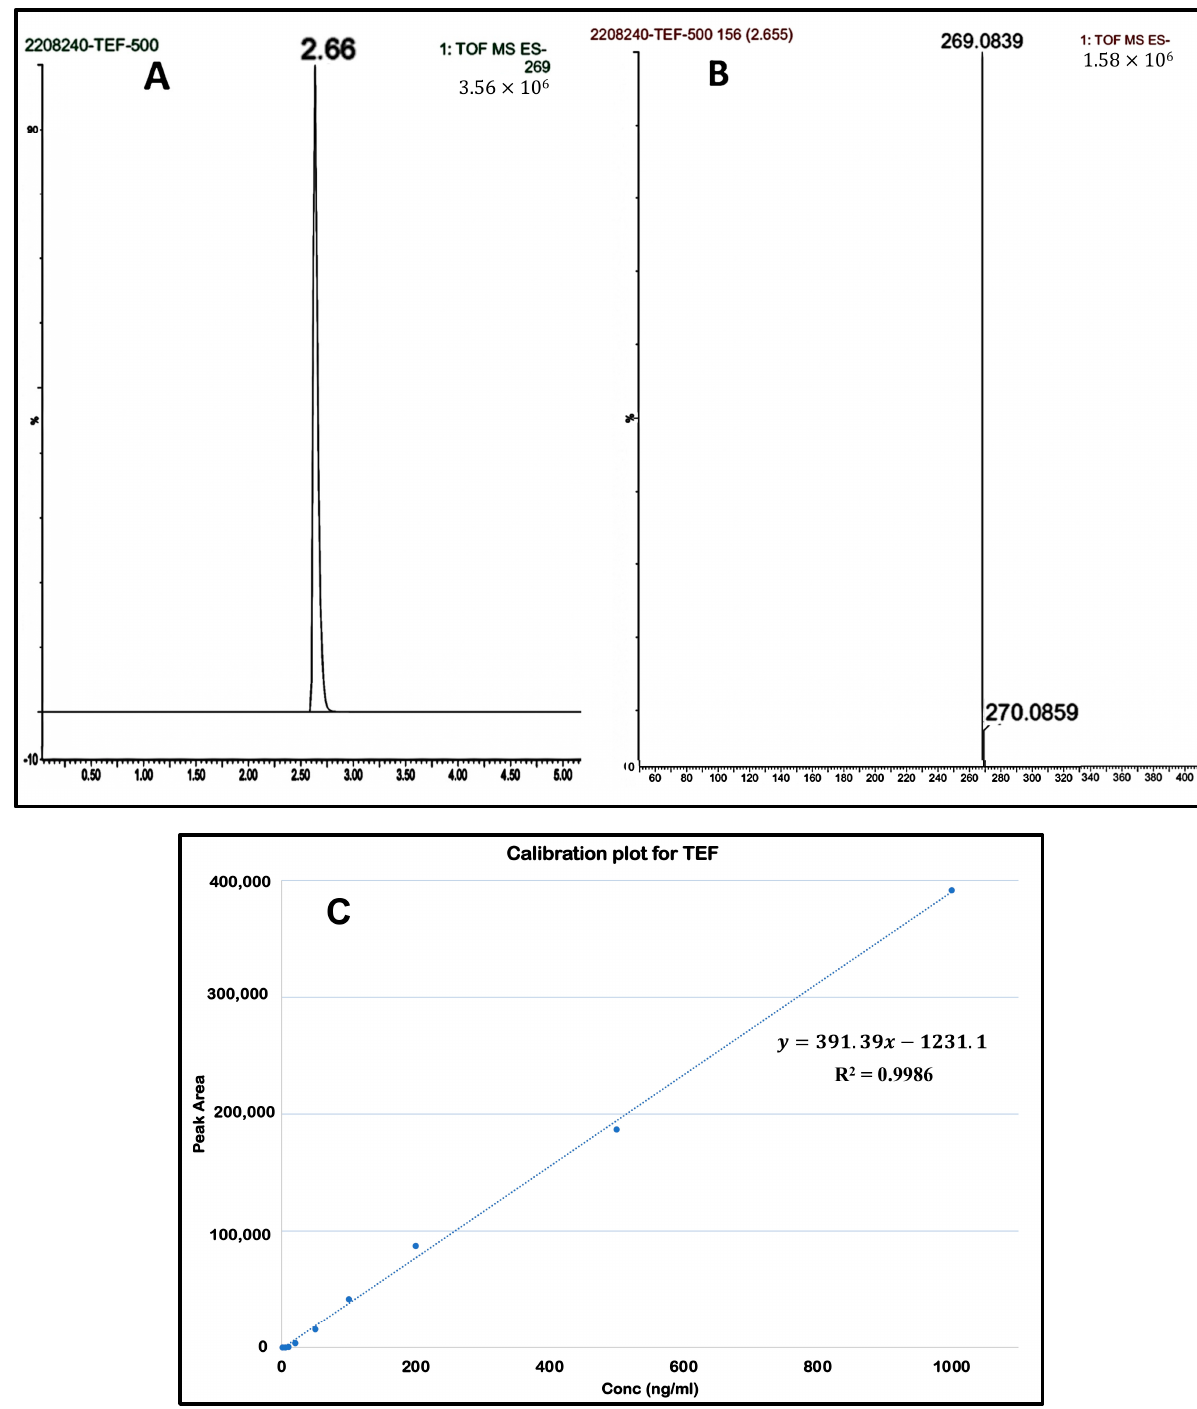
Figure 3. UPLC-MS TEF chromatograms. ( A ) Chromatogram for 500 ng/mL standard concentration with a retention time of 2.647 min. ( B ) Chromatogram obtained from the analysis of TEF representing m/z values. ( C ) Calibration curve of TEF in triplicates.